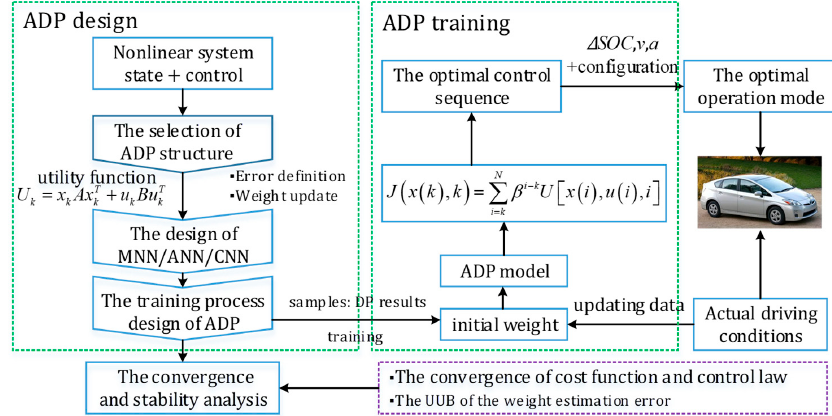
Figure 12. Depiction of the main steps in applying ADP to achieve energy management control.